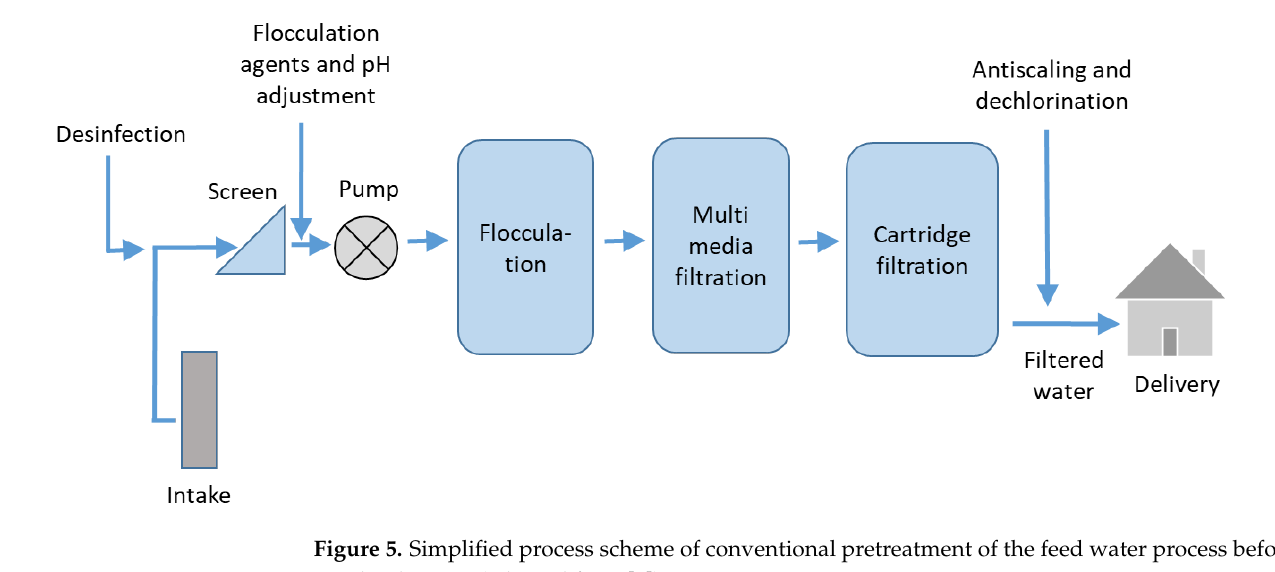
Figure 5. Simplified process scheme of conventional pretreatment of the feed water process before RO desalination (adapted from [1]).